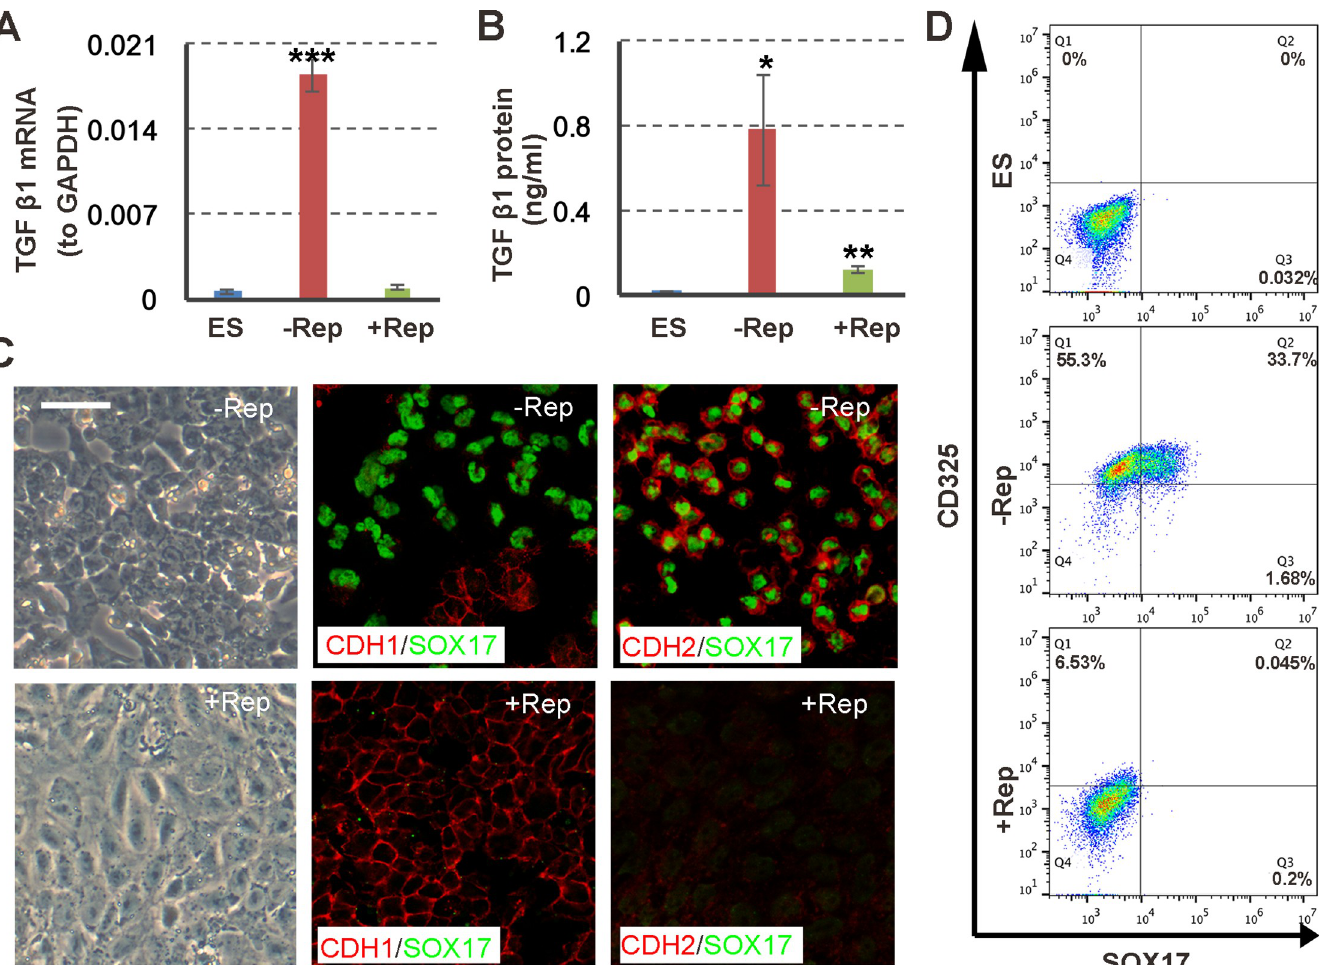
Fig 1. Inhibition of TGF- β signaling after PS induction disrupts endoderm specification. (A) TGF- β 1 expression levels in un-induced human embryonic stem cells (hESCs) assessed by RT-qPCR, or in activin differentiation medium with or without Repsox (Rep) treatment after PS induction (day 0–1). The expression level of GAPDH was arbitrary set as 1. Shown are the means ± s.d. of three replicates. ��� P < 0.001, compared to ES. (B) Concentrations of secreted TGF- β 1 in medium containing activin A with or without Repsox (Rep) on day 3, measured using an ELISA. Shown are the means ± s.d. of three replicates. � P < 0.05; �� P < 0.01, compared to ES. (C) Photos and immunofluorescence images of activin A-induced cells with or without Repsox (Rep) treatment. The scale bar indicates 20 μ m. (D) Flow cytometry analysis of activin A-induced cells with or without Repsox treatment.